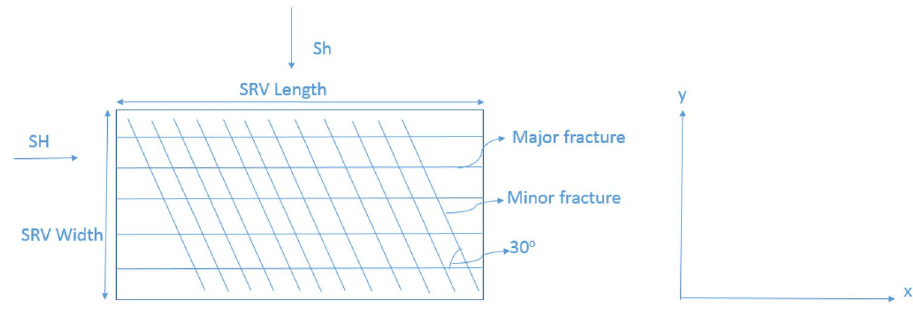
Fig. 16 Procedure to compute fracture aperture, number and